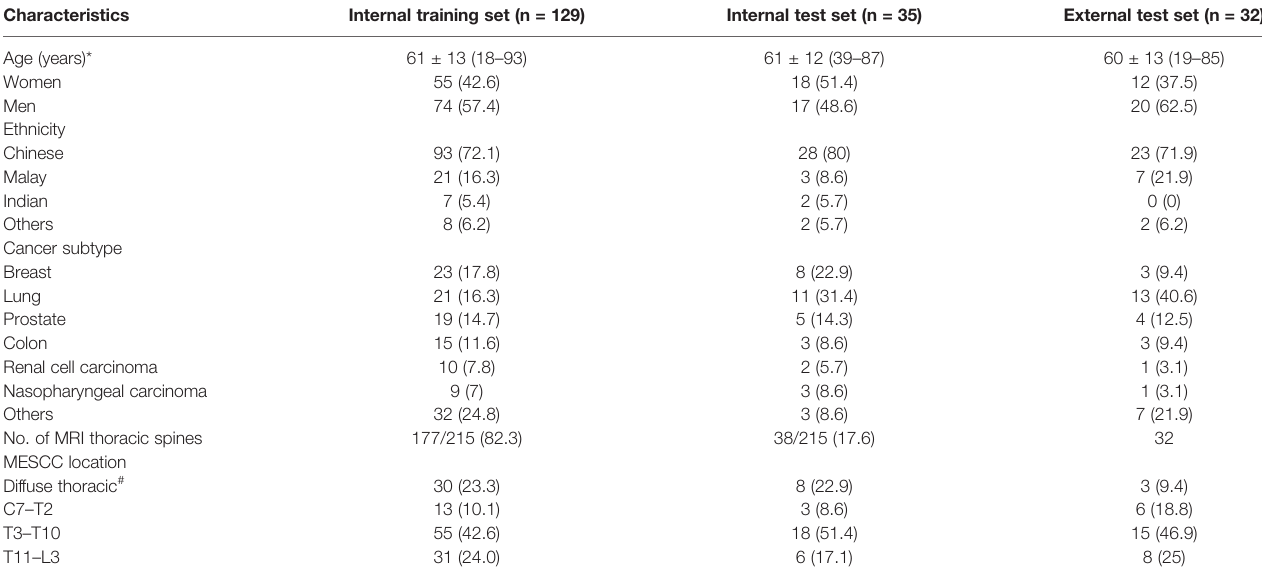
TABLE 1 | Patient demographics and clinical characteristics for the internal and external test sets.